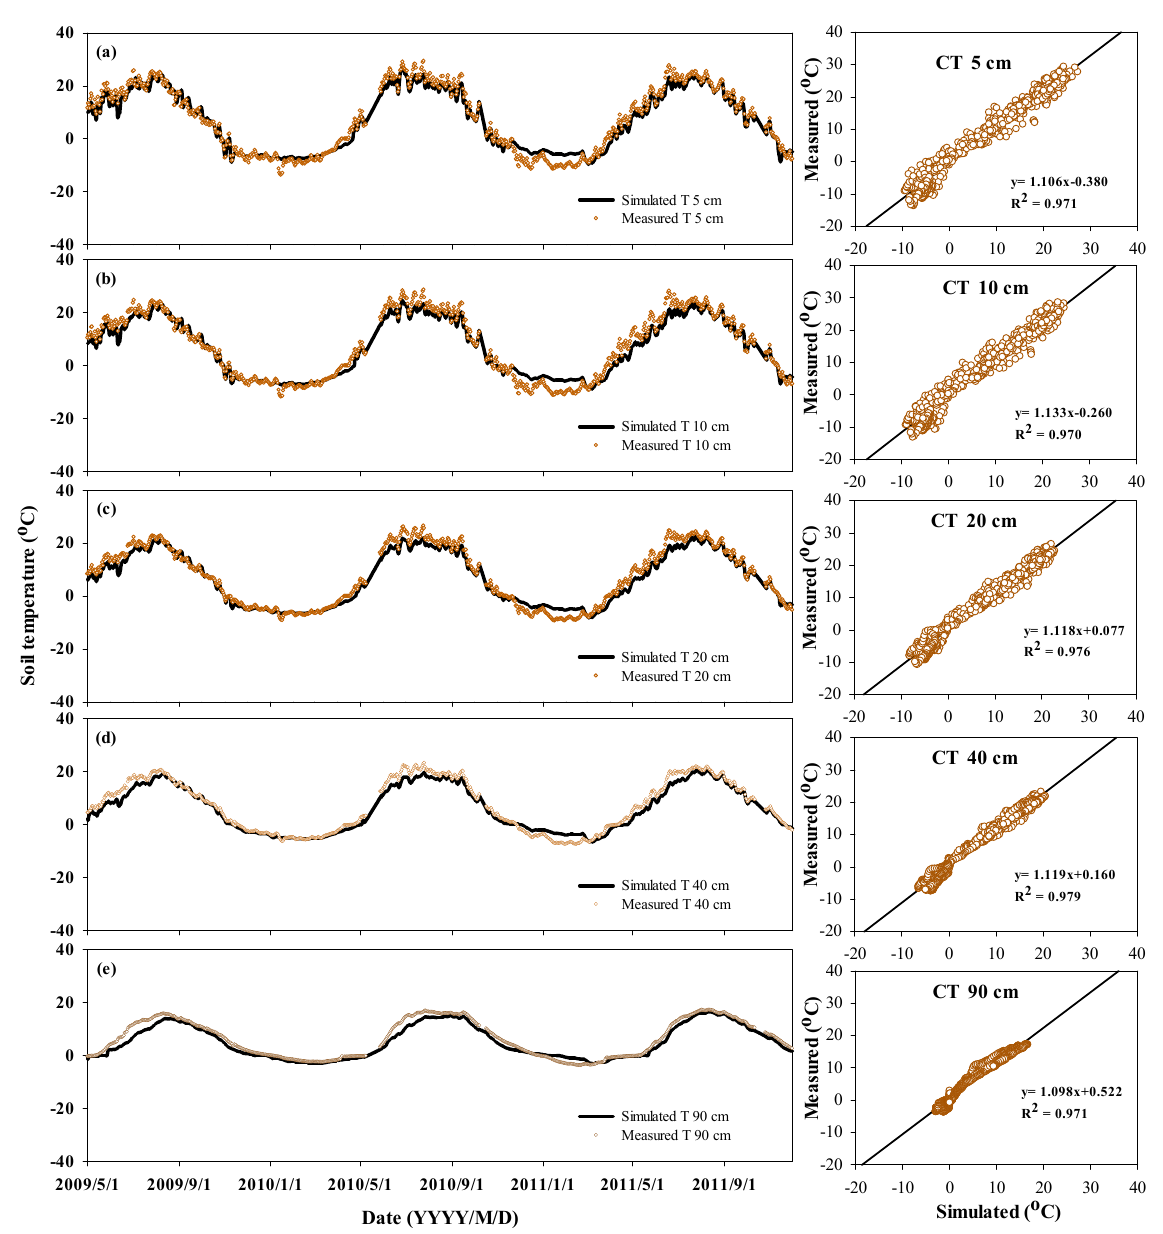
Figure 2. Simulations vs. measurements of daily soil temperatures at ( a ) 5 cm, ( b ) 10 cm, ( c ) 20 cm, ( d ) 40 cm, and ( e ) 90 cm for CT during 2009–2011.